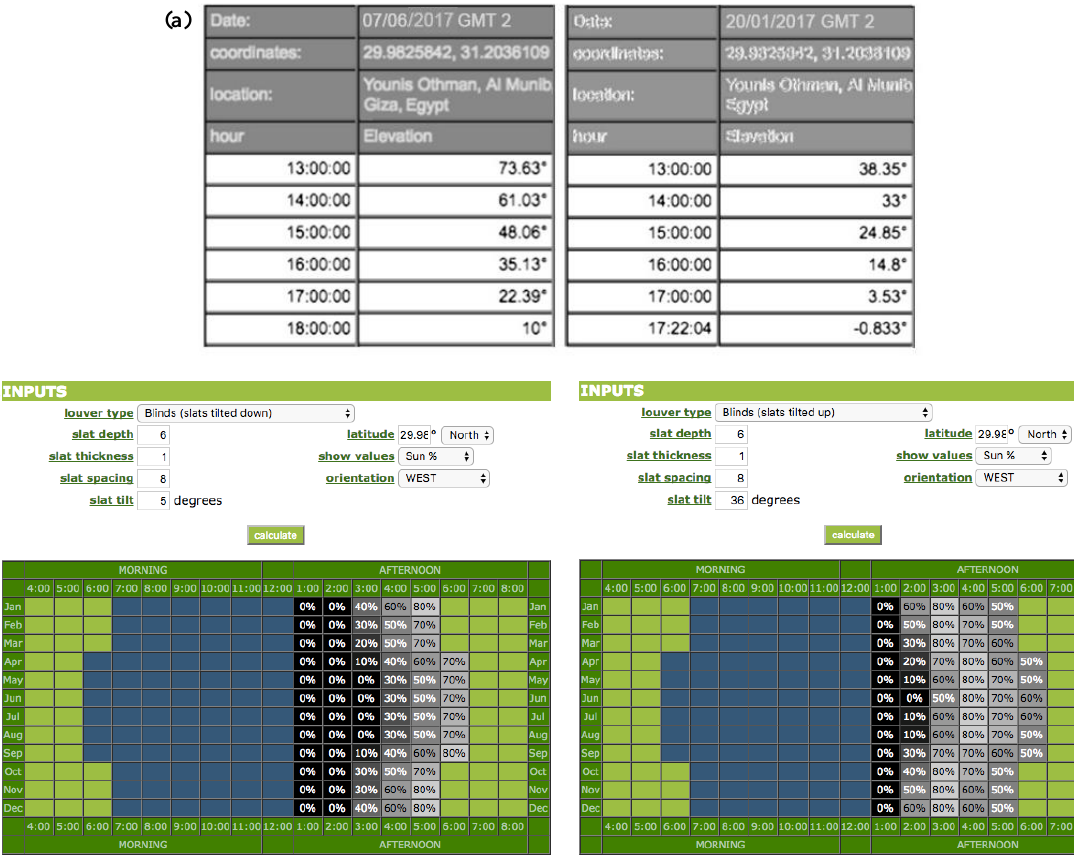
Figure 5 (a) Snapshots of the elevation angles for the sun’s rays durin g the hottest and coldest times of the year which were used to calculate the average needed angle for preventing and allowing the maximum amount of direct light from 1 pm to 4 pm in the winter and summer receptively using the MS (sunearthtools.com,